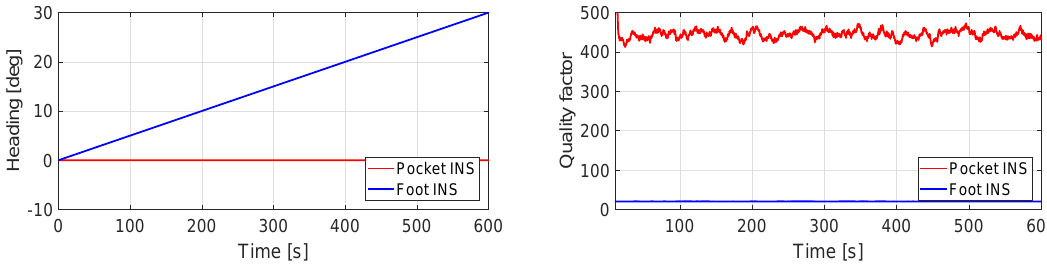
Figure 10. ( Left ) Heading estimation of the pocket INS and the foot INS of a still IMU. The turn rate measurements to the pocket INS have no bias. The turn rate measurements to the foot INS have a 0.05 ◦ /s constant bias in the z -axis; ( Right ) Quality factor estimation of the heading